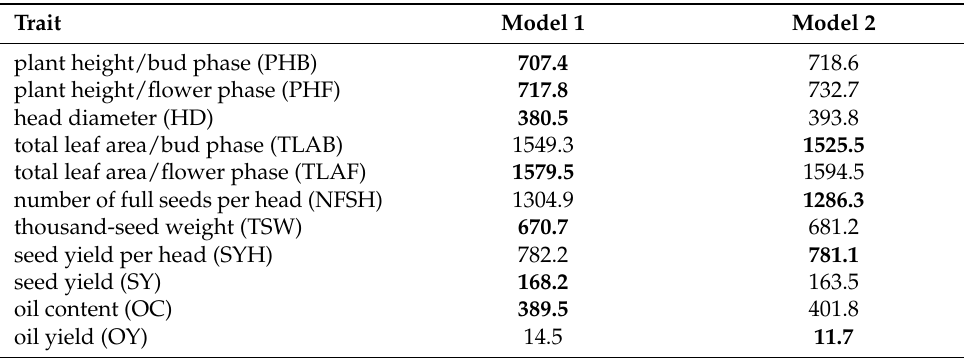
Table 2. Bayesian Information Criteria statistics for Model 1 and